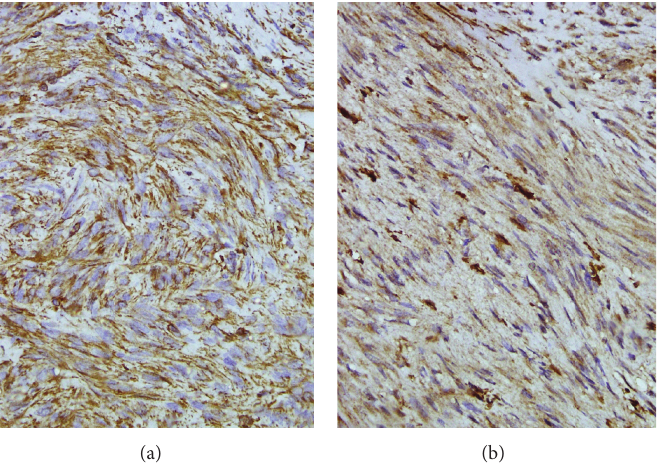
Figure 6: (a) Tumor cells demonstrating immunoreactivity for vimentin (antivimentin × 400), (b) tumor cells demonstrating nuclear and cytoplasmic immunoreactivity for S-100 (anti S-100 ×